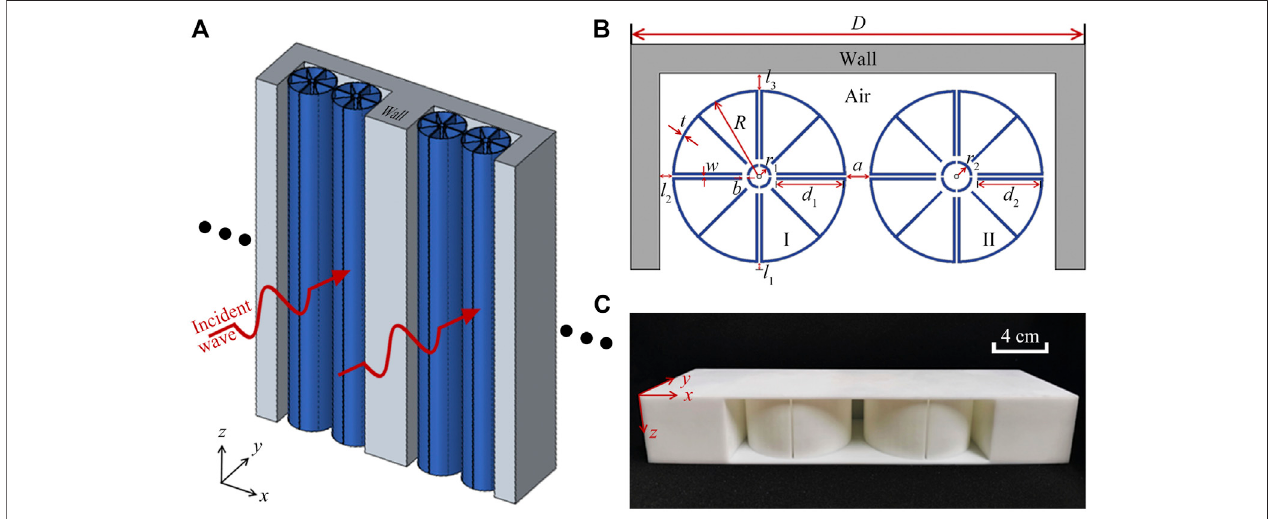
FIGURE 1 | (A) Schematic of an ultrathin planar wall with sound absorption, which is composed of periodic unit cells. (B) Cross section of the unit cell, (C) and sample photograph.